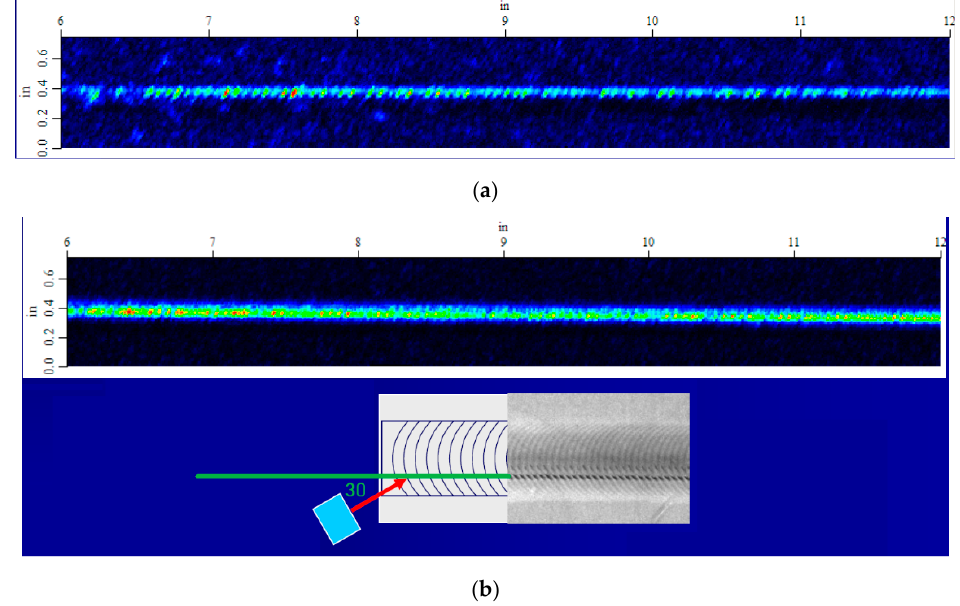
Figure 8. Immersion C-scan ultrasonic imaging at 10 MHz using 45° shear wave with probe skewed approximately 30° (azimuth) from weld line for ( a ) “very small: 0.0007 mm 2 ”, and ( b ) “large: 0.0472 mm 2 ”wormhole defect sizes [65].